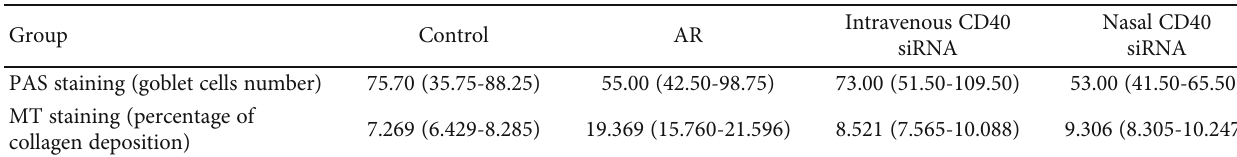
Table 2: Histopathology results of tissue remodelling.